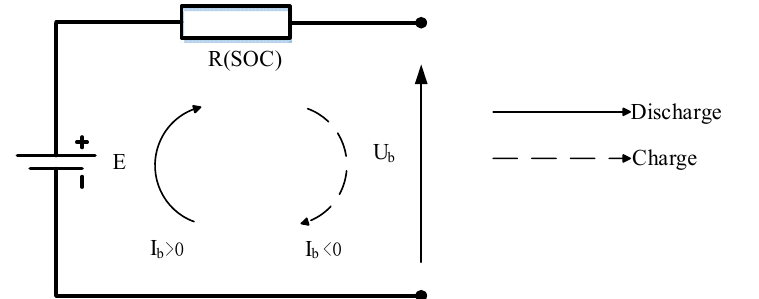
Figure 4 . Internal resistance model of the battery. Figure 4. Internal resistance model of the